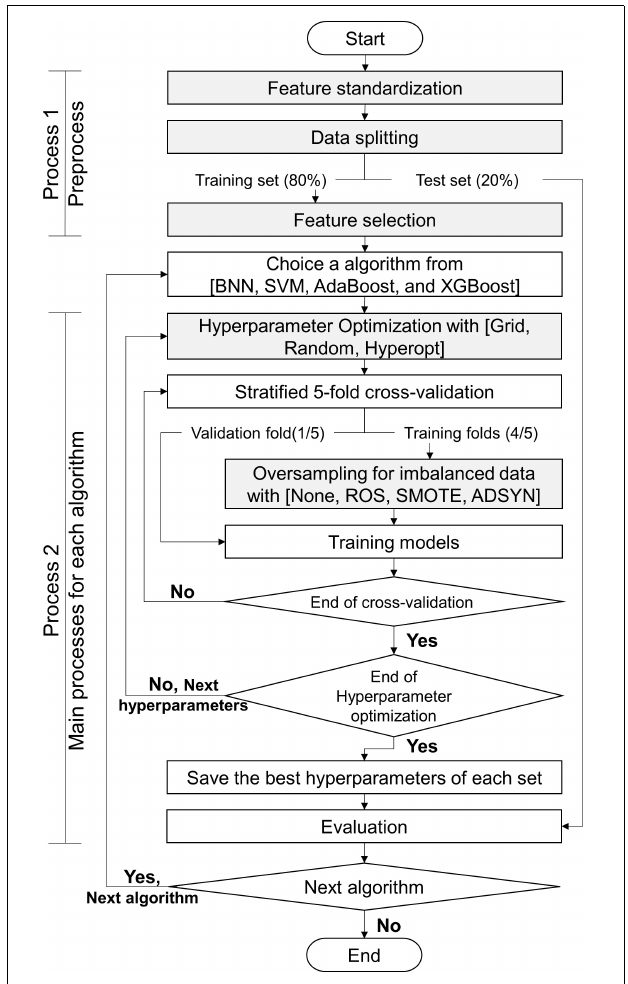
FIGURE 5 | Flowchart of this